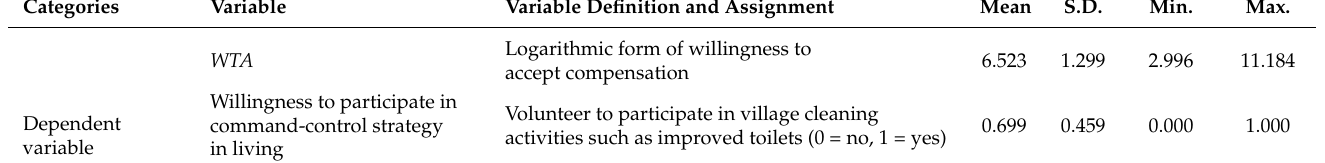
Table 1. Descriptive statistics of